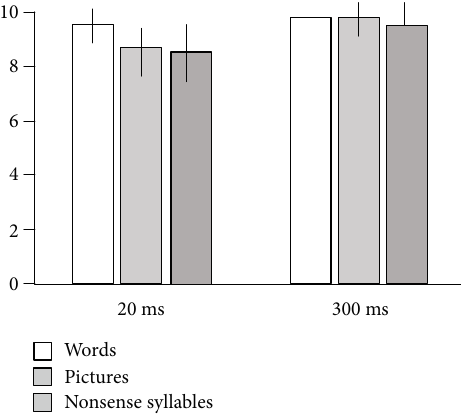
Figure 2: E ff ect of the types of stimuli in the HC group. HC = healthy control. The y -axis represents the average number of correct answers with SD. There was no signi fi cant di ff erence among the three types of stimuli (pictures, words, and nonsense syllables) in the two-way ANOVA with repeated measures ( F = 1 : 08 , p = 0 : 359 ), with the presentation time e ff ect ( F = 9 : 52 , p = 0 : 012 ), and with no interaction ( F = 1 : 32 , p = 0 : 285 ).